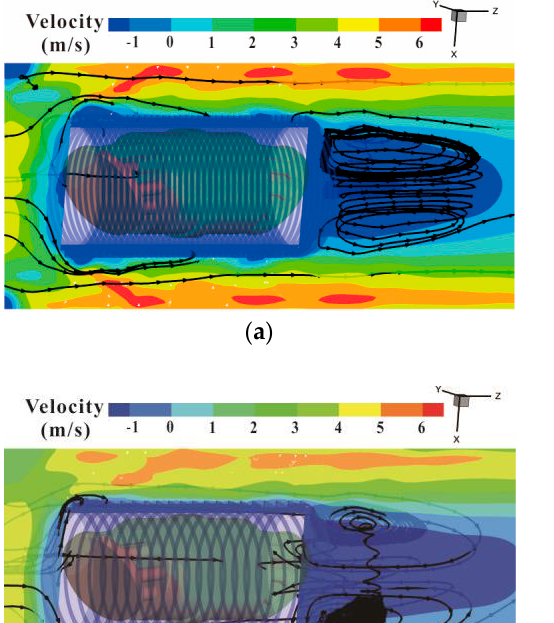
Figure 11. Velocity distribution with a fin height h = 10 mm and fin thickness t = 2 mm when ( a ) fin pitch p = 10 mm; ( b ) fin pitch p = 15 mm; ( c ) fin pitch p = 20 mm; ( d ) fin pitch p = 25 mm.